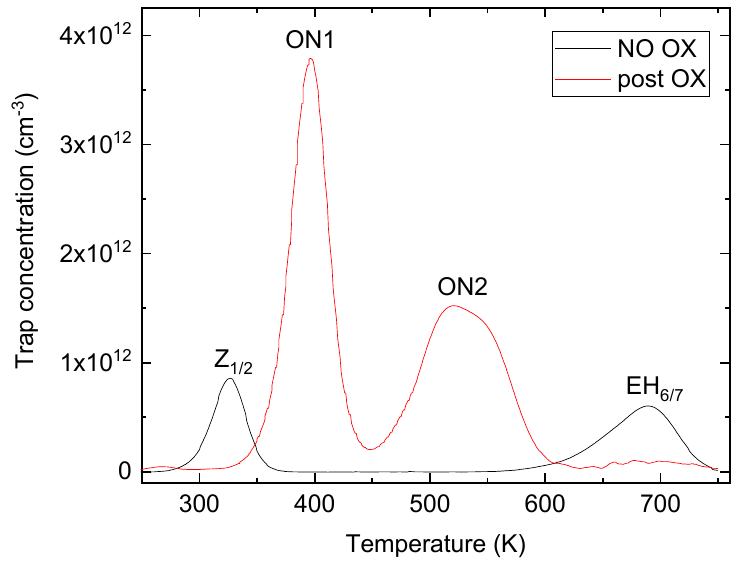
Figure 2. Deep level transient spectroscopy (DLTS) measurements on non-oxidated (black line) and post-oxidated (red line) samples with the appearance of new ON1 and ON2 centers.